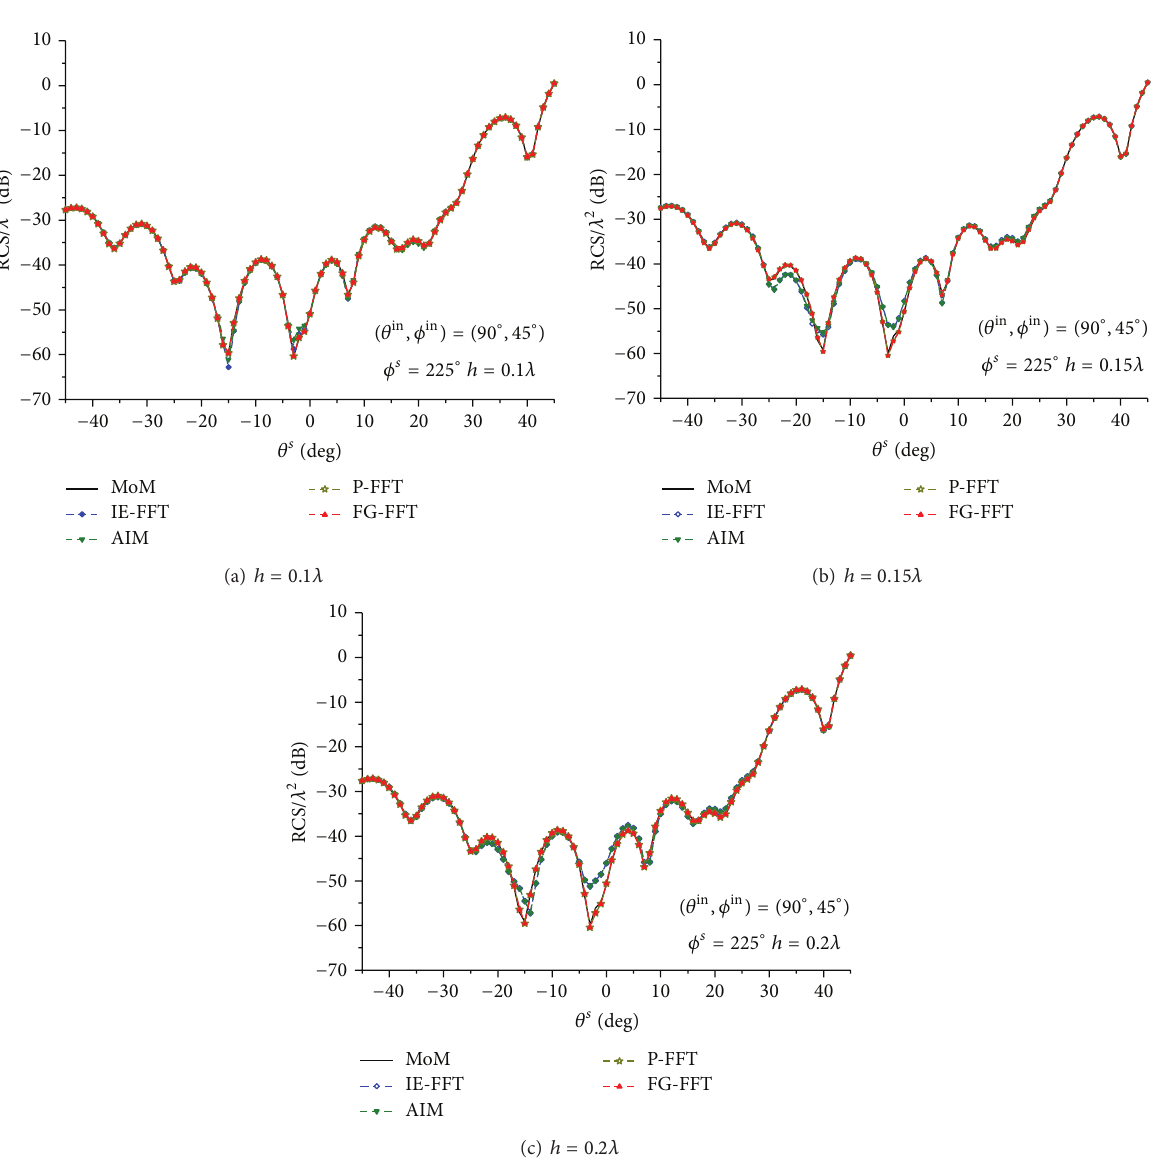
Figure 8: Bistatic RCS curves of the partitioned homogeneous dielectric slab in Example